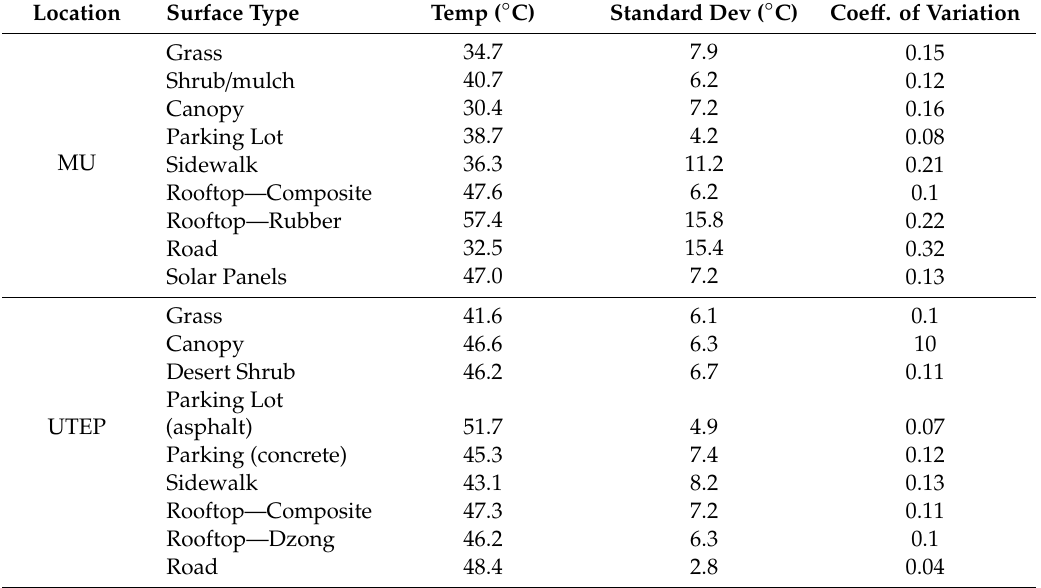
Table 5. Average temperature, standard deviation and coe ffi cient of variation of nine surface types From 14 recorded flights on Marquette University campus and from one flight recorded on UTEP’s